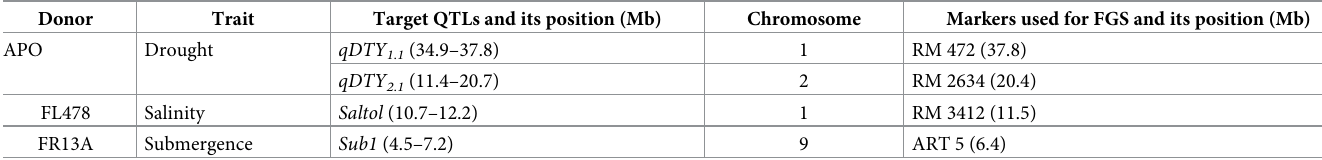
Table 3. Details of markers identified for foreground selection of target QTLs.